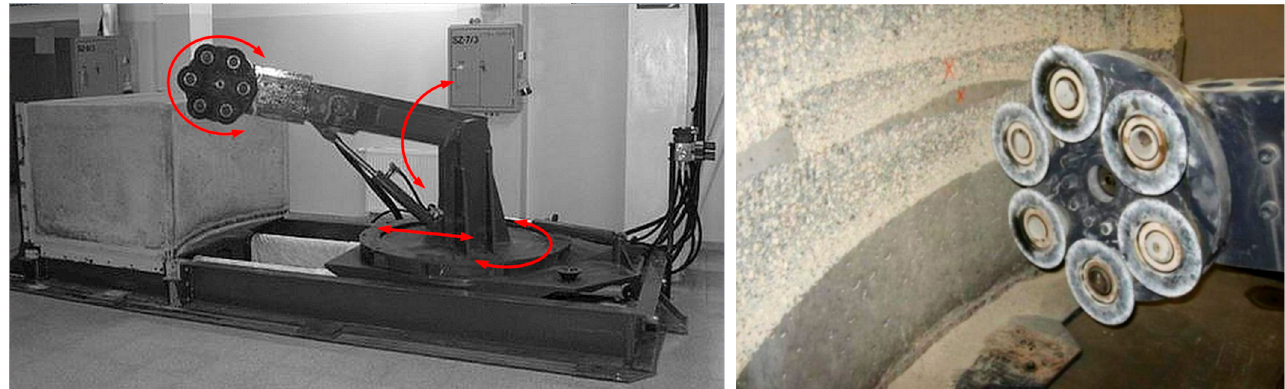
Figure 13. Bench with a rotating cutter head placed on an arm for testing discs [39].